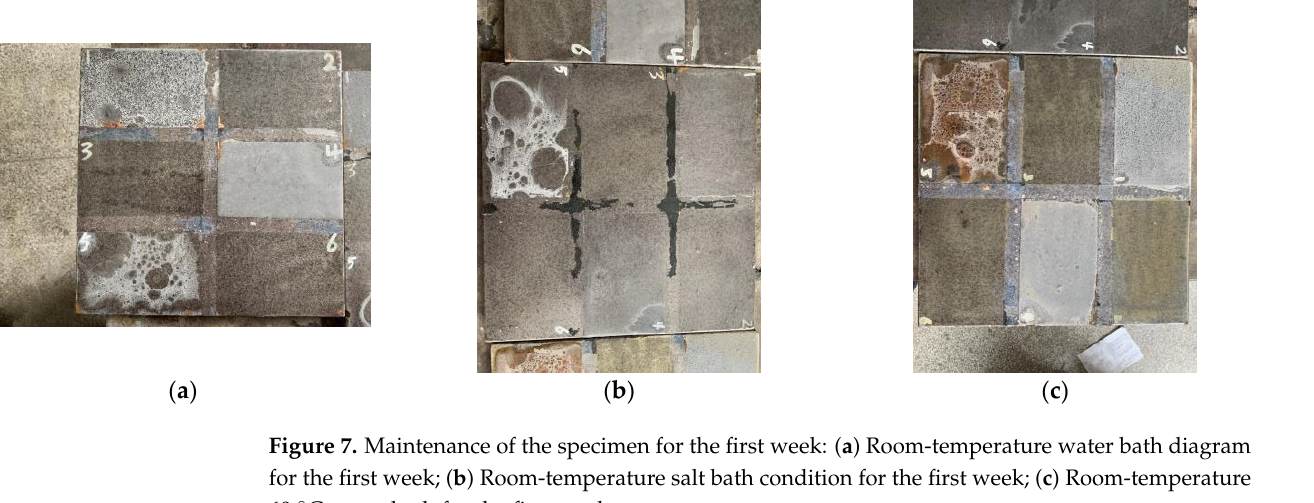
Figure 8. Room temperature water bath drawing strength diagram.